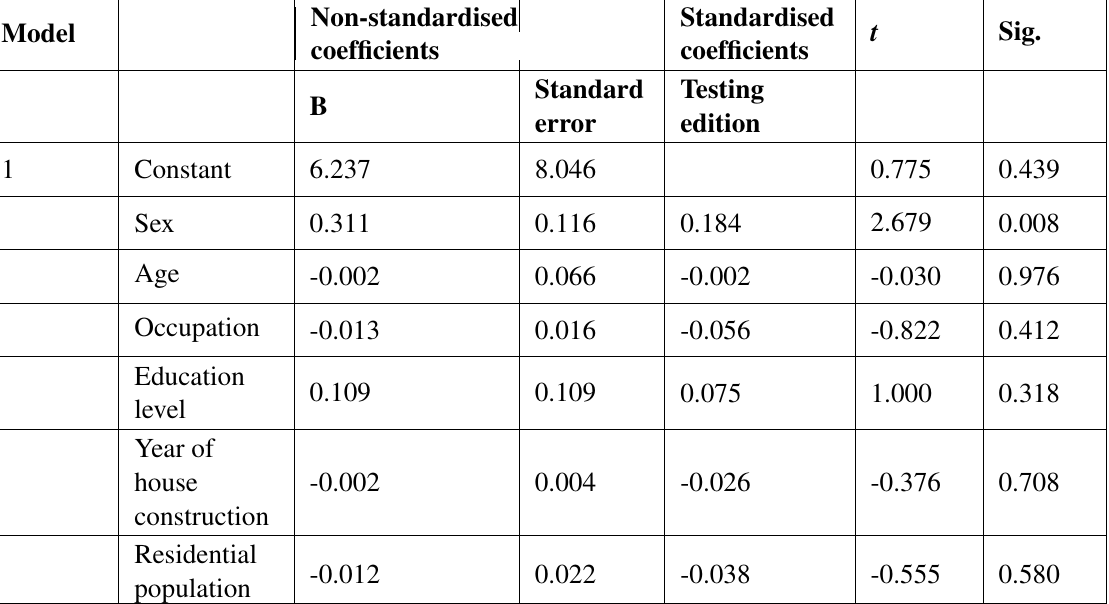
Table 7 Coefficients a of relevant social influence